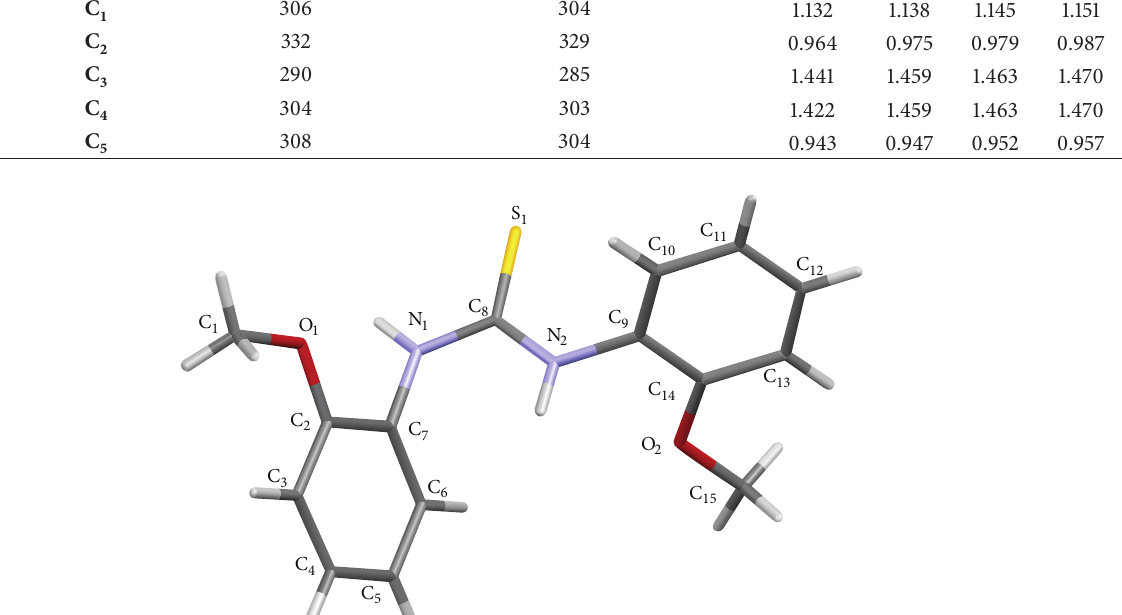
S. number Code of the complex 𝜆 max of the complex 𝜆 max of the complex after DNA addition